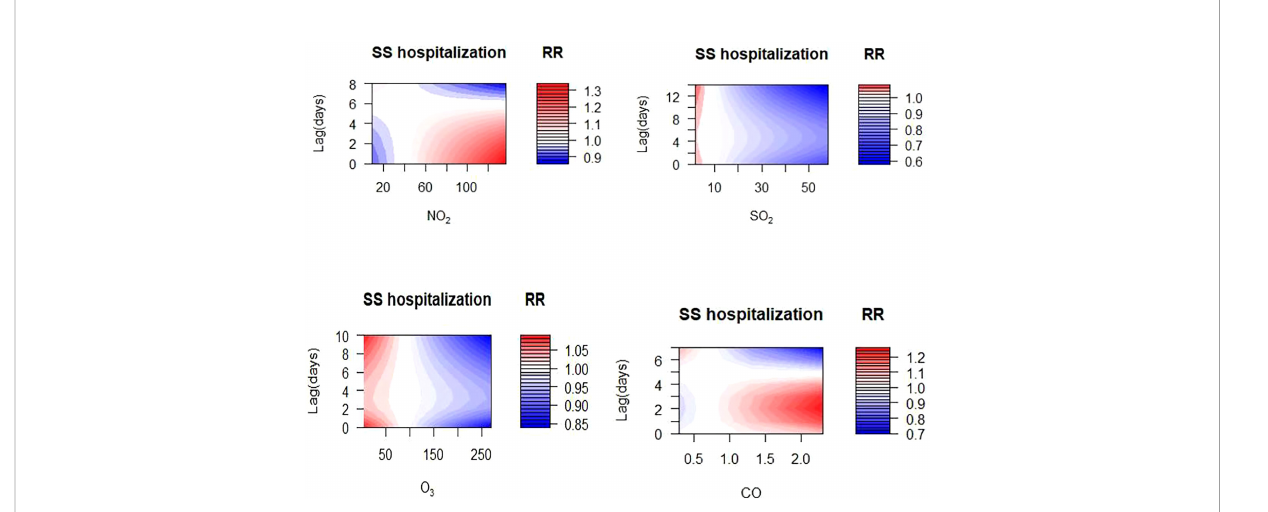
FIGURE 2 Contour plots for relative risk of hospitalizations for SS admissions along NO 2 , SO 2 , O 3 and CO at lag periods in